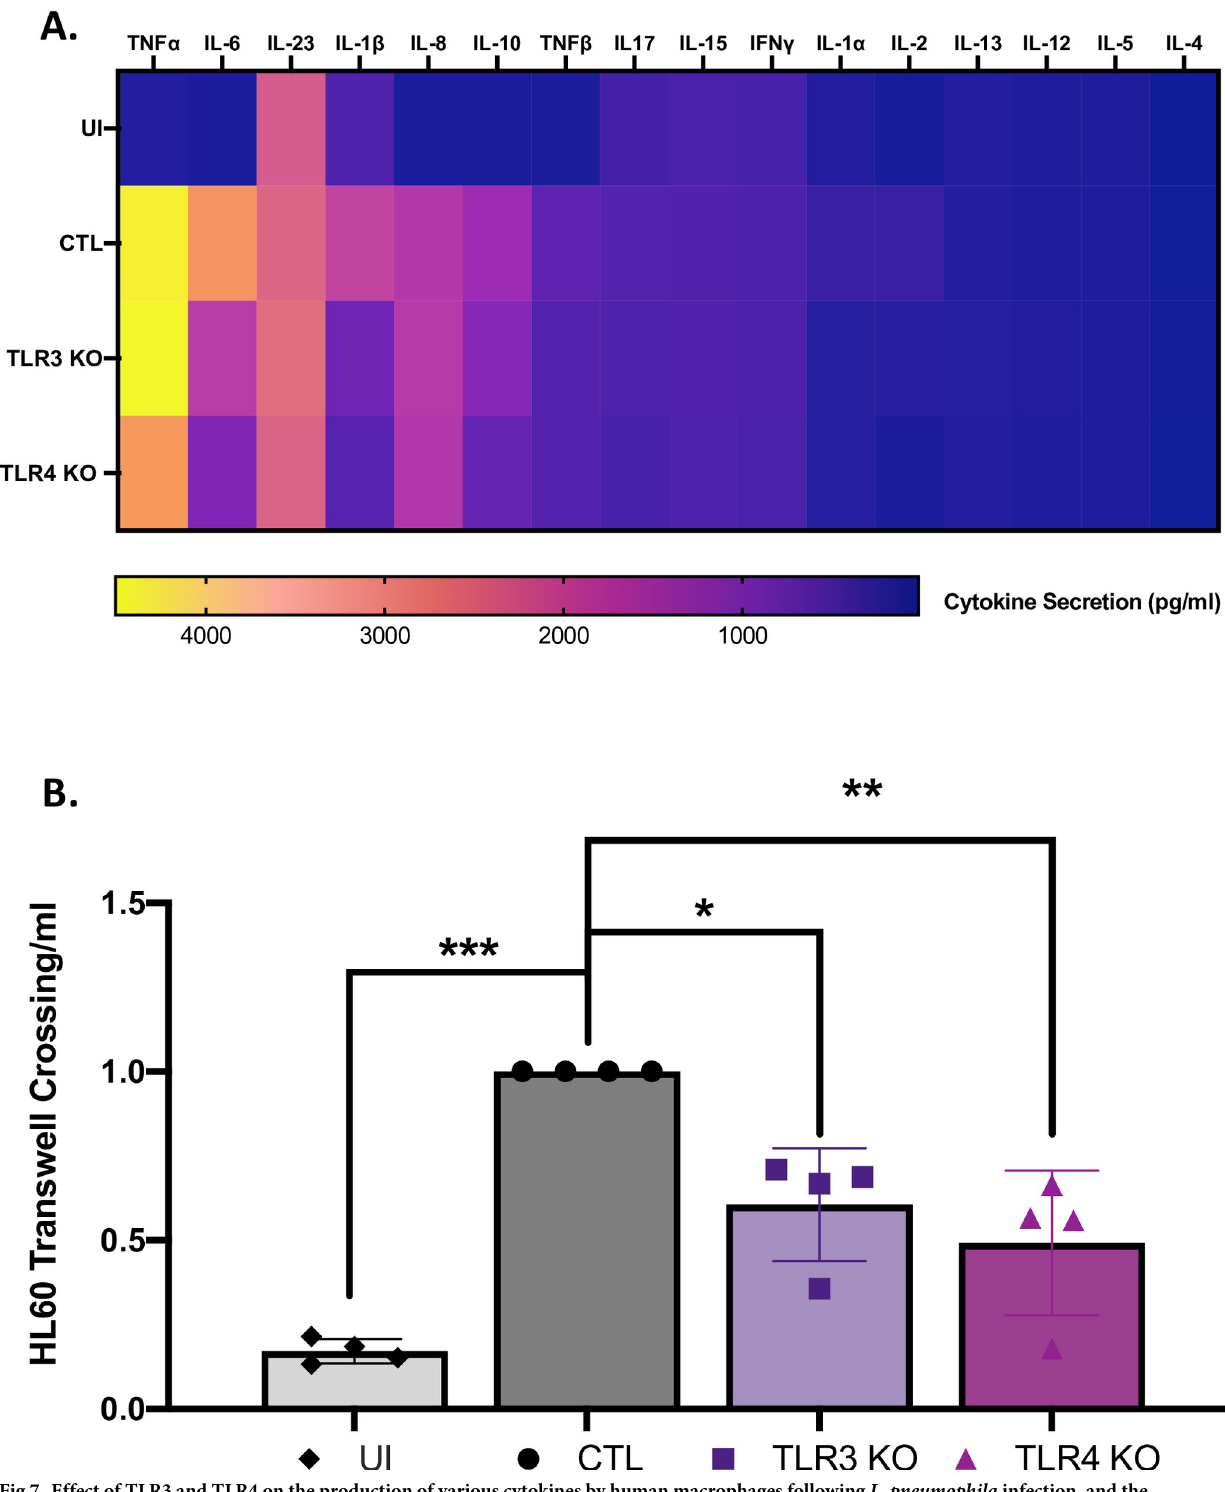
Fig 7. Effect of TLR3 and TLR4 on the production of various cytokines by human macrophages following L . pneumophila infection, and the chemotactic activity of that TLR3- and TLR4-dependent response. (A) U937 expressing a non-targeting CRISPR guide plasmid were either not infected (UI) or infected with strain 130b at a MOI of 20 (CTL), and the levels of sixteen different cytokines in culture supernatants were ascertained after 9 h by multiplex ELISA analysis, with the pg/ml levels presented using the indicated color scheme. U937 cells containing a KO of TLR3 or TLR4 (TLR3 KO,